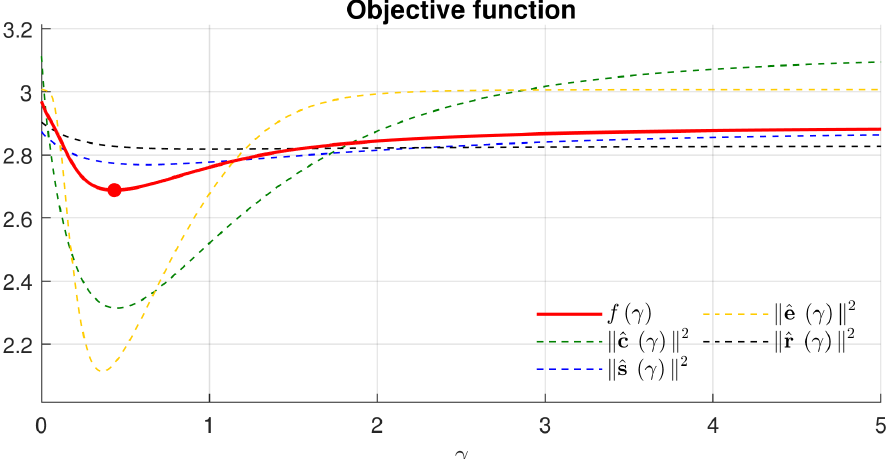
Figure 8. The grid search of γ ∗ (taking I v in the top row of Figure 5 as an